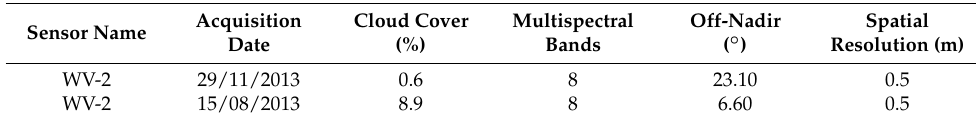
Table 3. Selected images for processing (digitization and classification). The spatial resolution is after pan-sharpening.